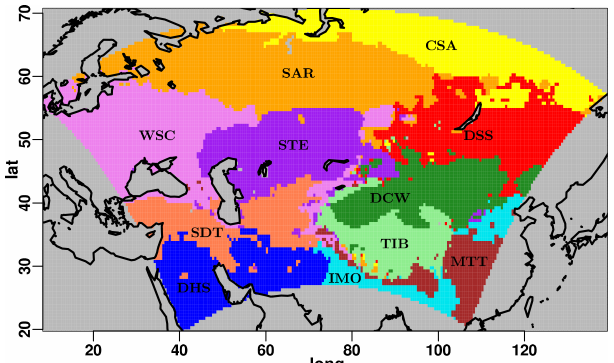
Figure 2. Map of the 11 subregions obtained through k -means clus- tering of q -normalized monthly climatologies of the three consid- ered variables over the period of